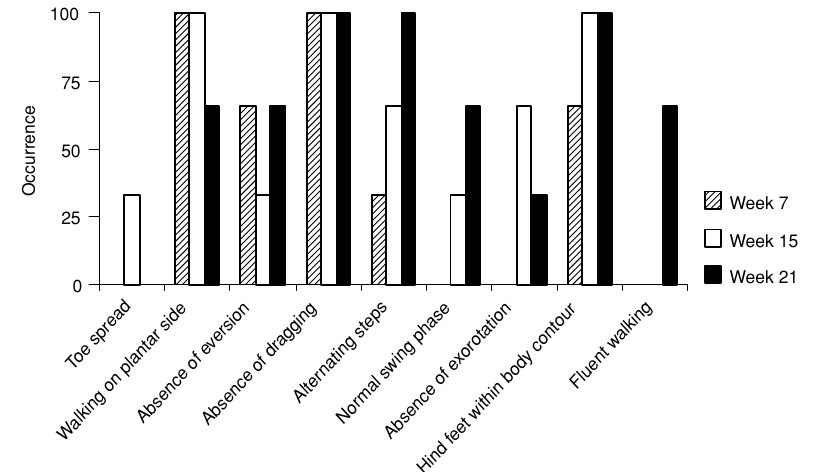
Figure 2 Histogram showing the percentages of rats with positive scores for each of the nine motoric behavioral parameters. For example, alternating steps is clearly improving in time.